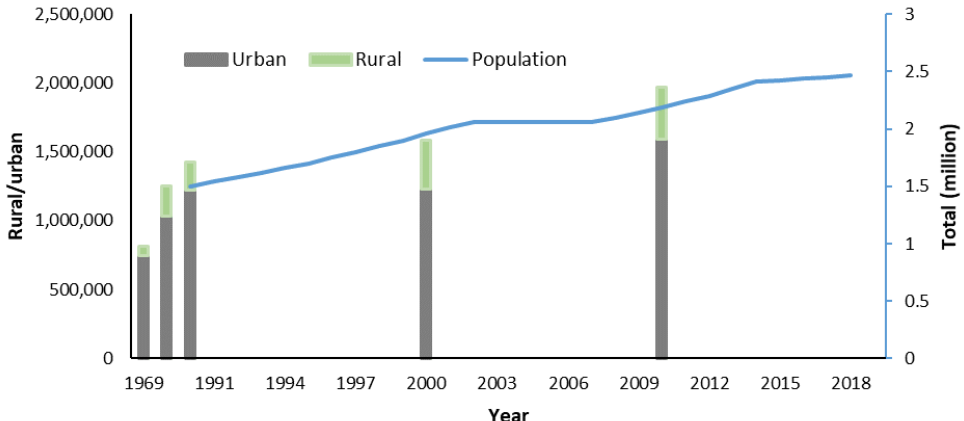
Figure 12. Rural, urban, and total population in Copperbelt. Data taken from Zambia Central Statistical Office.